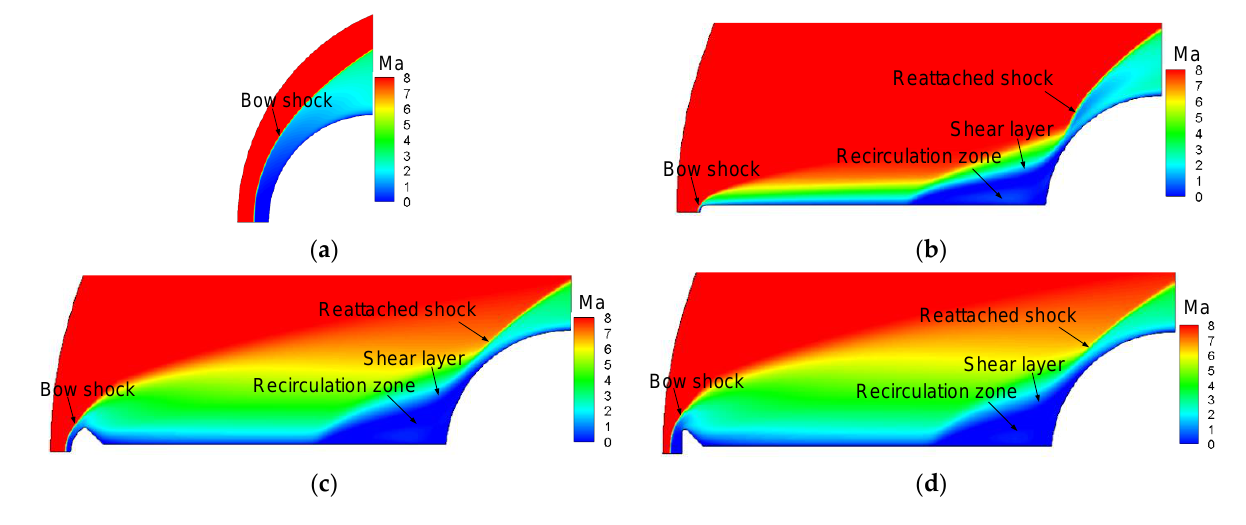
Figure 9. Flow field: ( a ) Model 1; ( b ) Model 2; ( c ) Model 3; ( d ) Model 4.